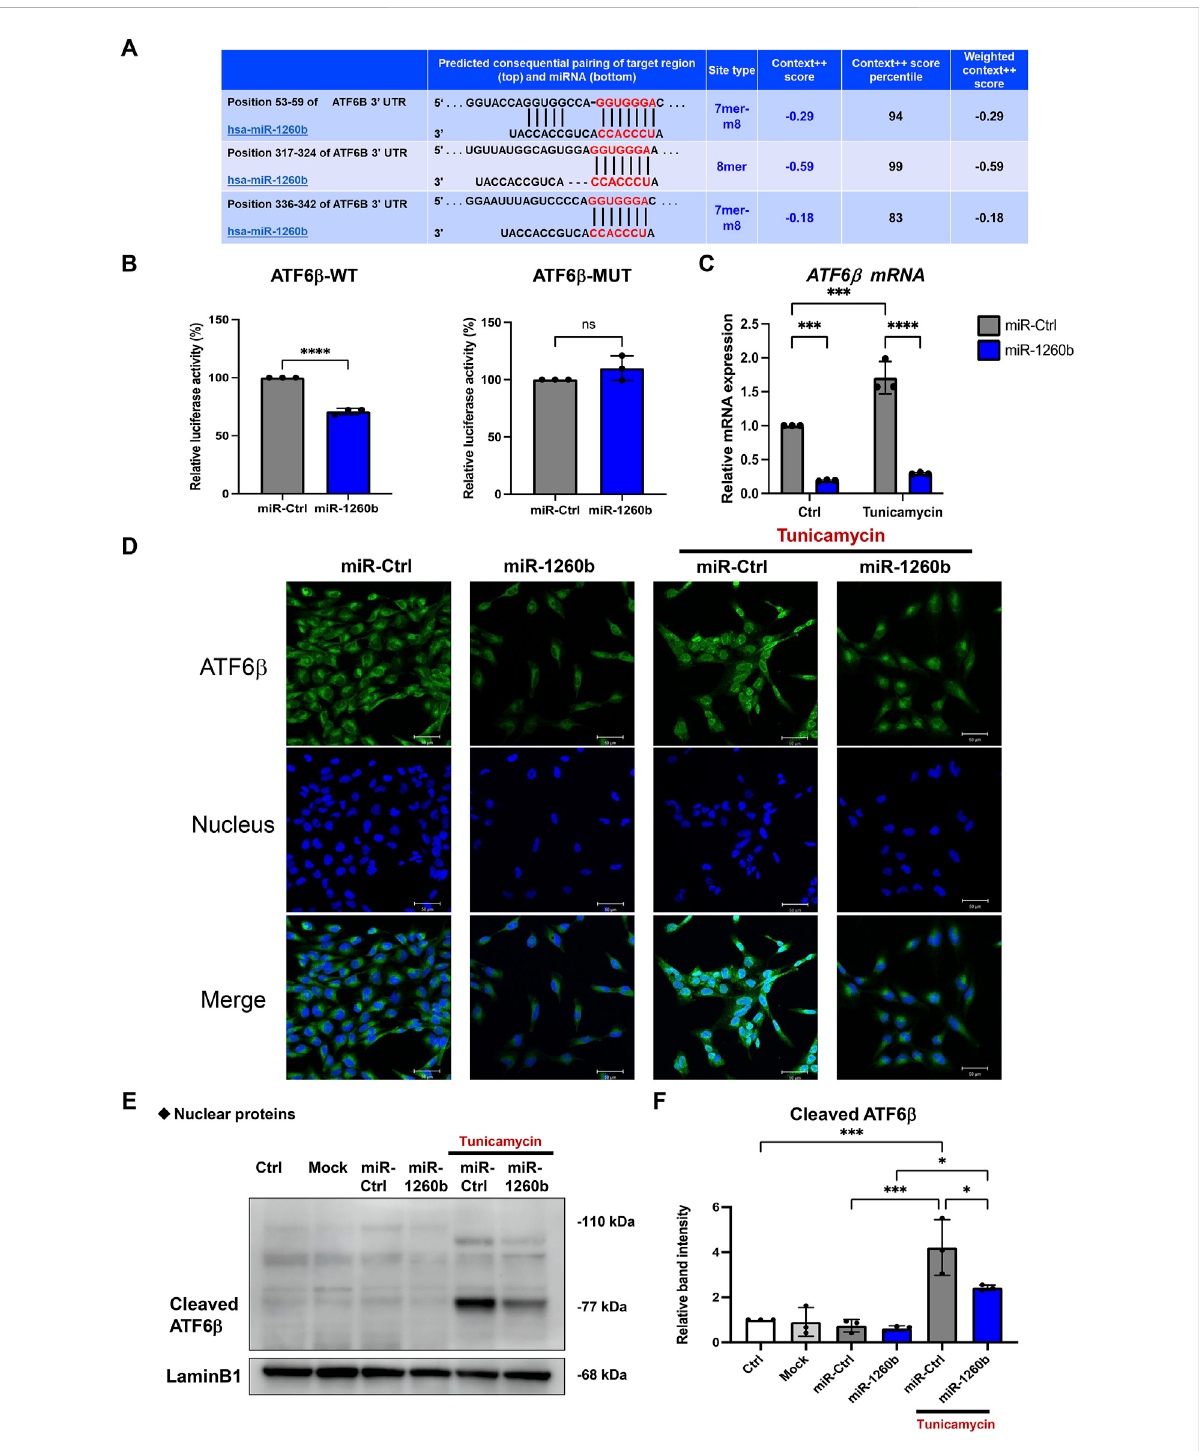
miR-1260b attenuates the endoplasmic reticulum (ER) stress-induced nuclear expression of cleaved ATF6 β in periodontal ligament (PDL) cells. (A) Binding sites (in red letters) between ATF6 β 3 ′ -untranslated region (UTR) and miR-1260b predicted on the TargetScan database. (B) Luciferase reporter vectors containing the wild type miR-1260b binding sites of ATF6 β (ATF6 β -WT) or mutated ATF6 β sequence (ATF6 β -Mut) were co- transfected with control miRNA (miR-Ctrl, 20 nM) or miR-1260b mimic (20 nM) into human primary PDL cells. After 24 h, fi re fl y luciferase activity in each sample was measured and normalized to the control (Renilla) luciferase activity. (C – E) Effect of miR-1260b on the expression of ATF6 β under ER stress. PDL cells were transfected with miR-Ctrl or miR-1260b for 24 h. After changing the medium, cells were stimulated